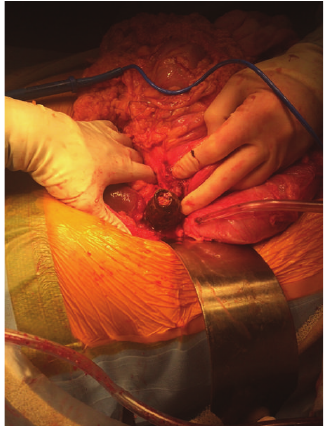
Figure 4: Intraoperative picture showing 7 cm gallstone causing obstruction at the proximal third of the transverse colon, with a cholecystocolic fistula communicating between the transverse colon and the gallbladder.